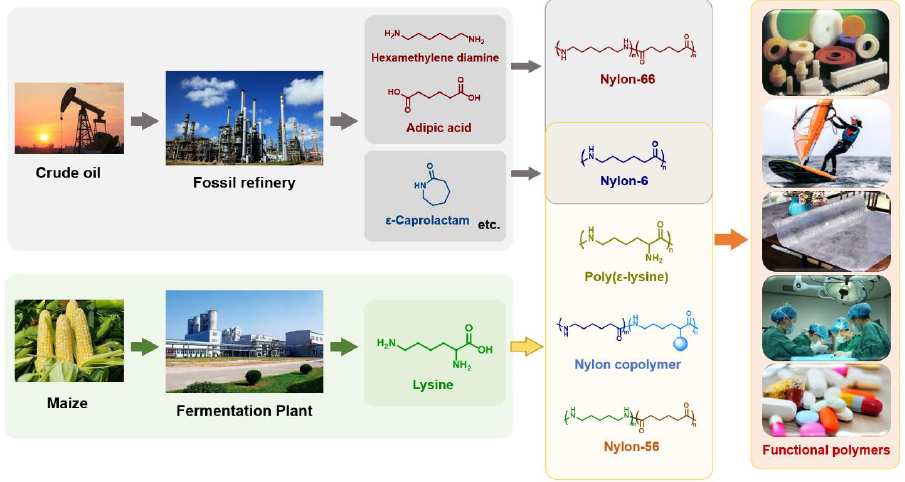
Figure 1. Fossil strategy and biological fermentation strategy for the production of monomers and the subsequent functional polymers.